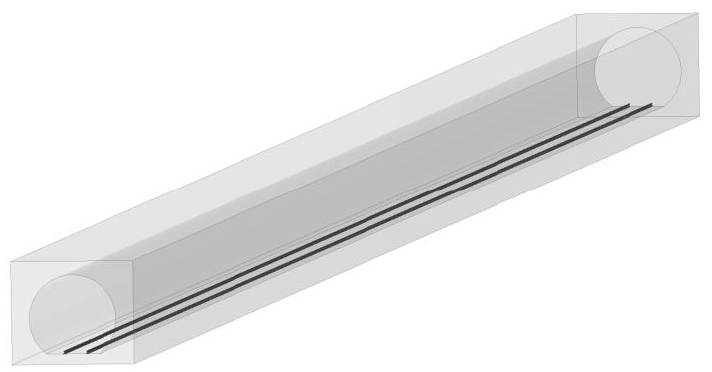
Figure 8. The 3D model of the straight tunnel.